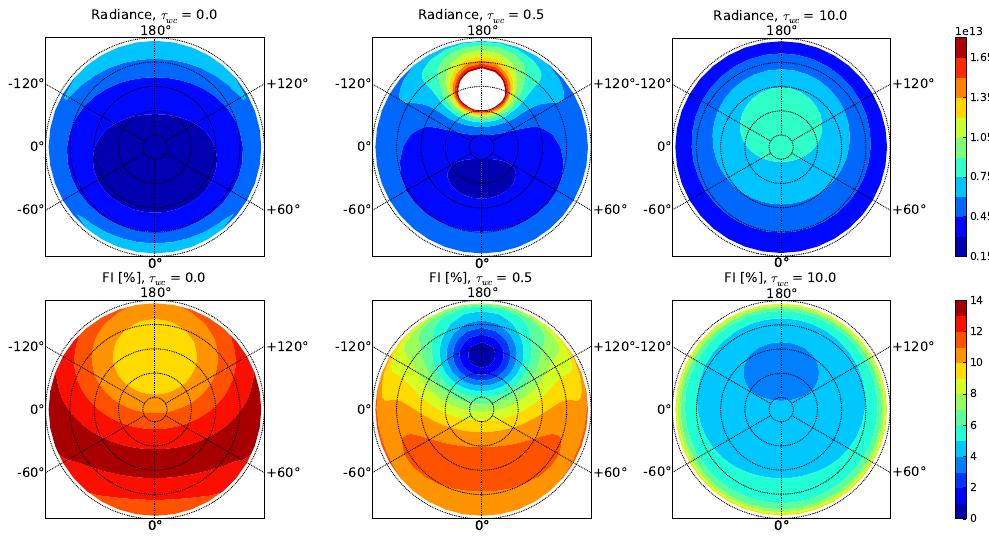
Fig. 5. The upper row shows the BOA radiances [photon/(s cm 2 nm sr)] at 393.37nm for cloudless, τ wc = 0 . 0, and cloud optical depths of 0.5 and 10.0. The simulations were made for the same conditions as in Fig. 4. The lower row shows corresponding FI factors. The circles indicate polar angles of 10, 30, 50, 70, and 90 ◦ moving outwards. The azimuth angles are shown on the